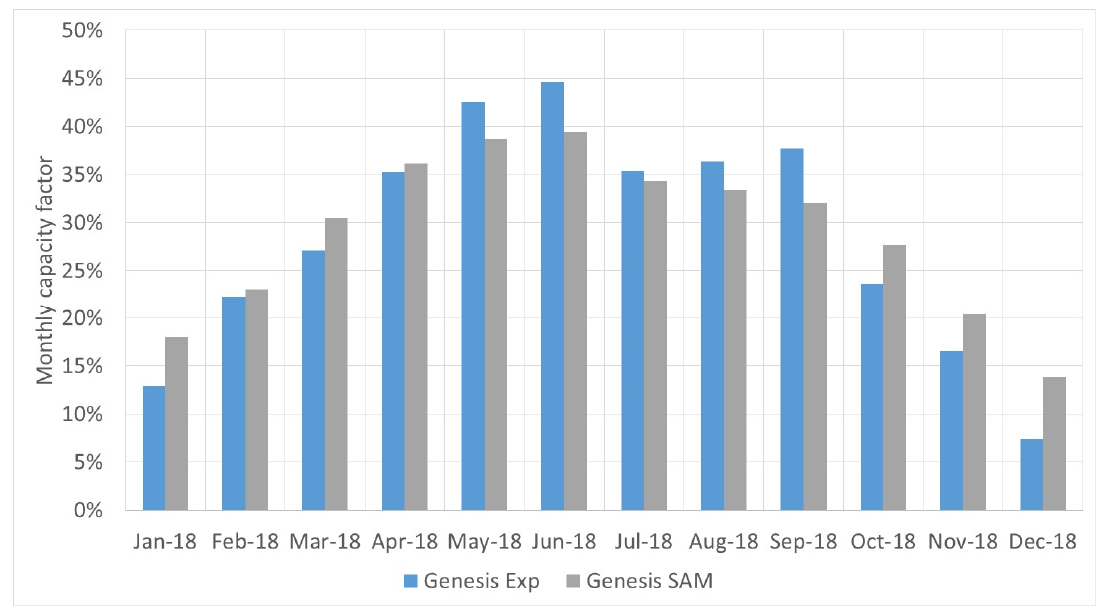
Figure 3. Comparison of monthly capacity factors of Genesis from SAM and measurements.